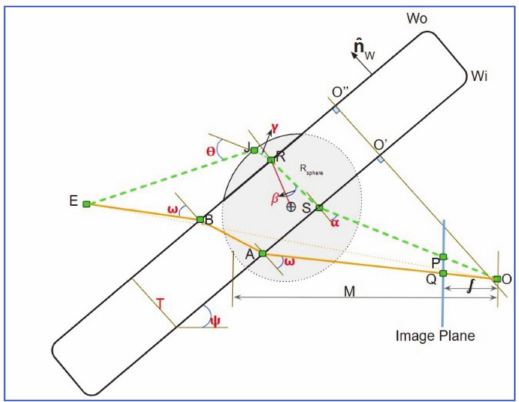
Figure 6. Refraction model of a raindrop on windshield [12]. Each raindrop pixel O in the image plane is traced to the environment point E using lows of light refraction (green line). Numerical calcuations are used to identify the path of the light beam emmitted from point E through the windshield glass only, to the same point O in the image plane (orange line). This ray-tracking method identifies which environment points are captured through the adherent raindrop on a windshield.